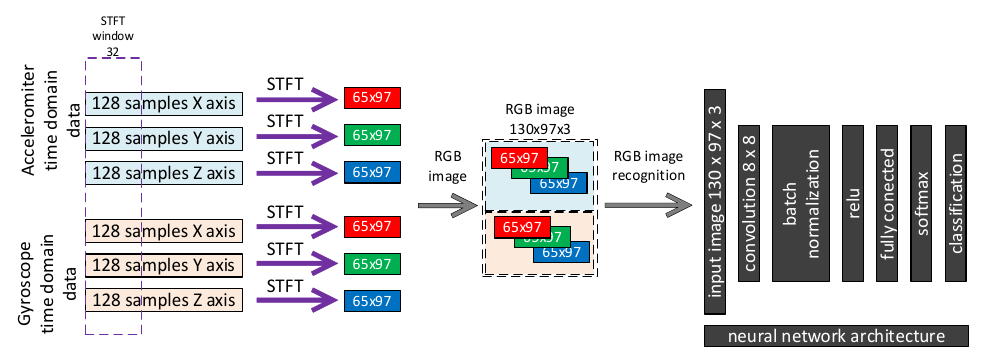
Figure 16. STFT RGB image creation and convolutional neural network architecture.